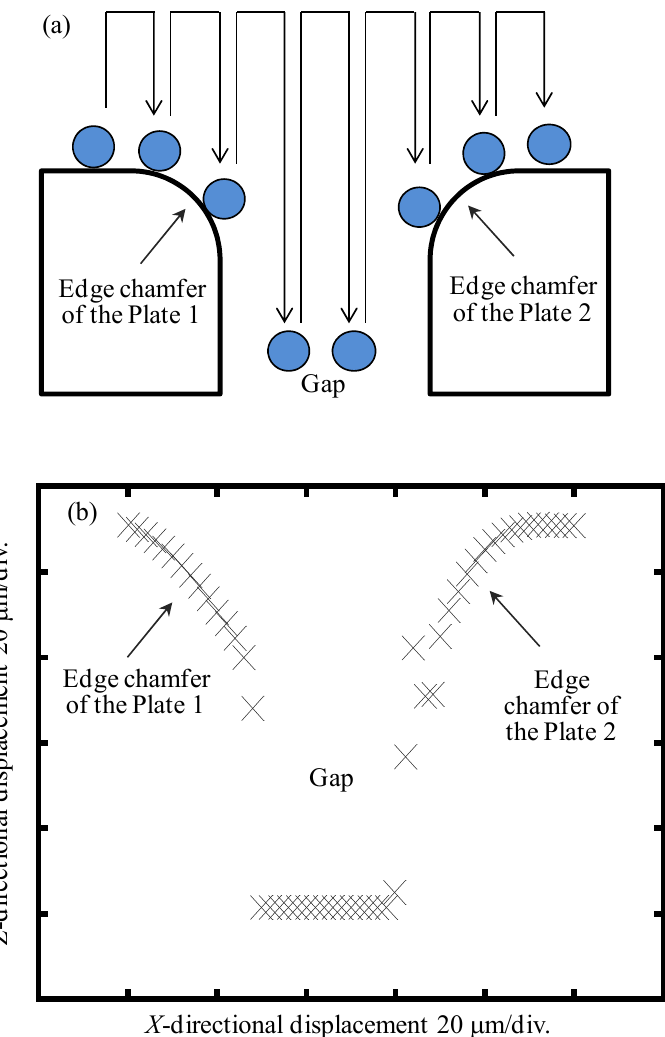
Figure 13. Chamfered edge detection by using the micro-probe: ( a ) Detection strategy of the chamfered edge; ( b ) Measurement result of the slit position.